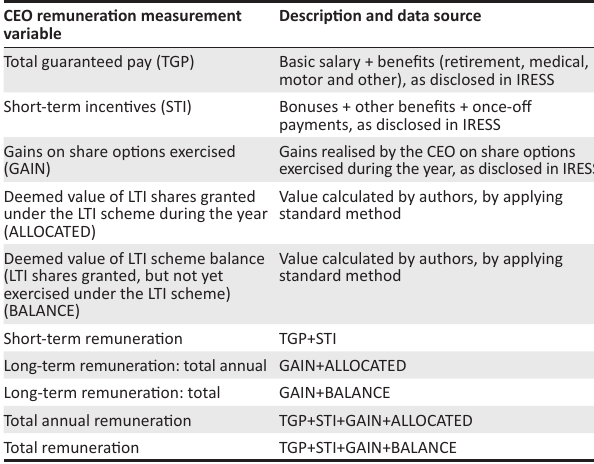
TABLE 1: Components of chief executive officer’s